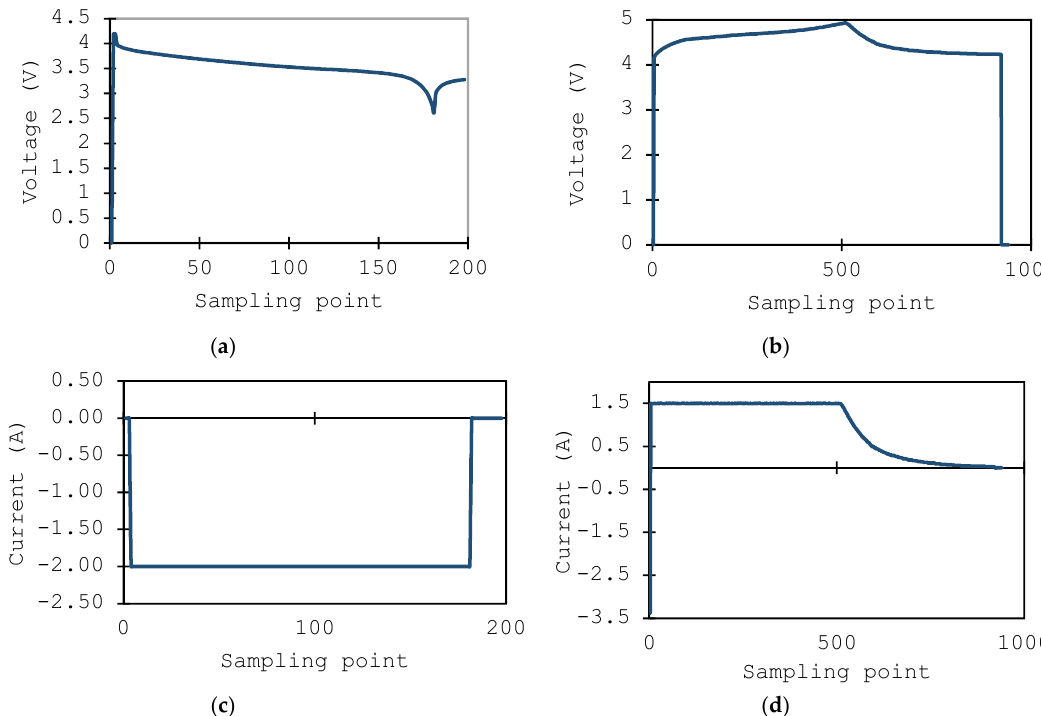
Figure 2. The current and voltage during the discharging and charging of battery No. 05: ( a ) the current of discharging, ( b ) the current of charging, ( c ) the voltage of discharging, and ( d ) the voltage of charging.